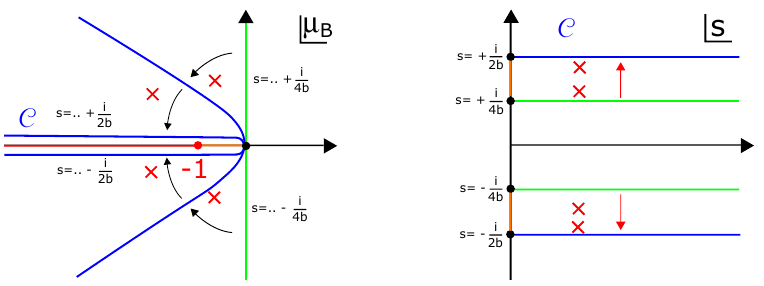
Figure 11 . Left: contour deformation ( C ) in the µ B -plane, and range of the variable s in the process. Right: contour deformation in the s -plane and possible poles. The small (orange) segments cancel out in the computation and can be